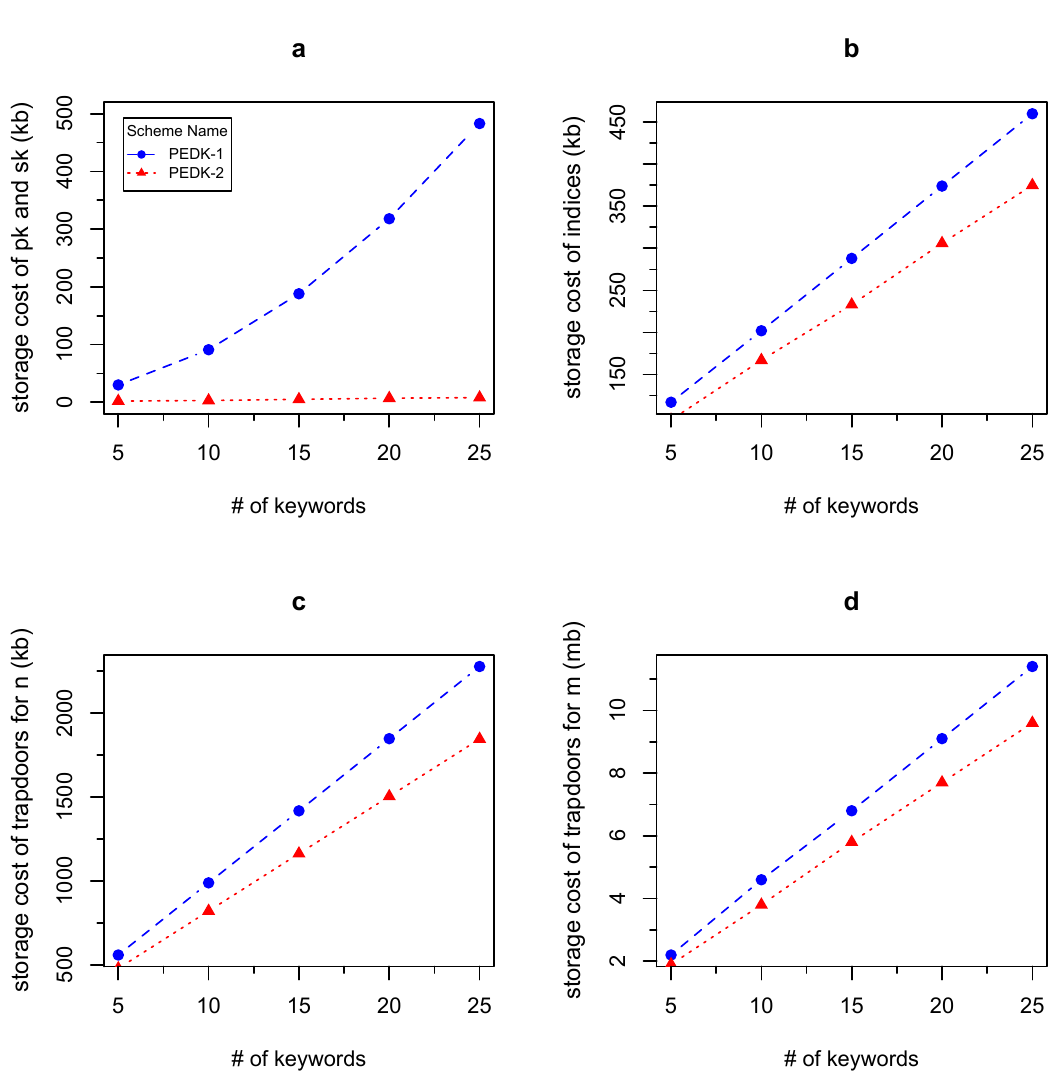
Figure 5. Impact of n on the storage cost of keys ( a ), indices ( b ) and trapdoors ( c ) in PEDK-1 and PEDK-2 ( D = 100, m = 5, n = { 5,10,15,20,25 } ); impact of m on the storage cost of trapdoors ( d ) in PEDK-1 and PEDK-2 ( D = 100, n = 5, m = { 5,10,15,20,25 }